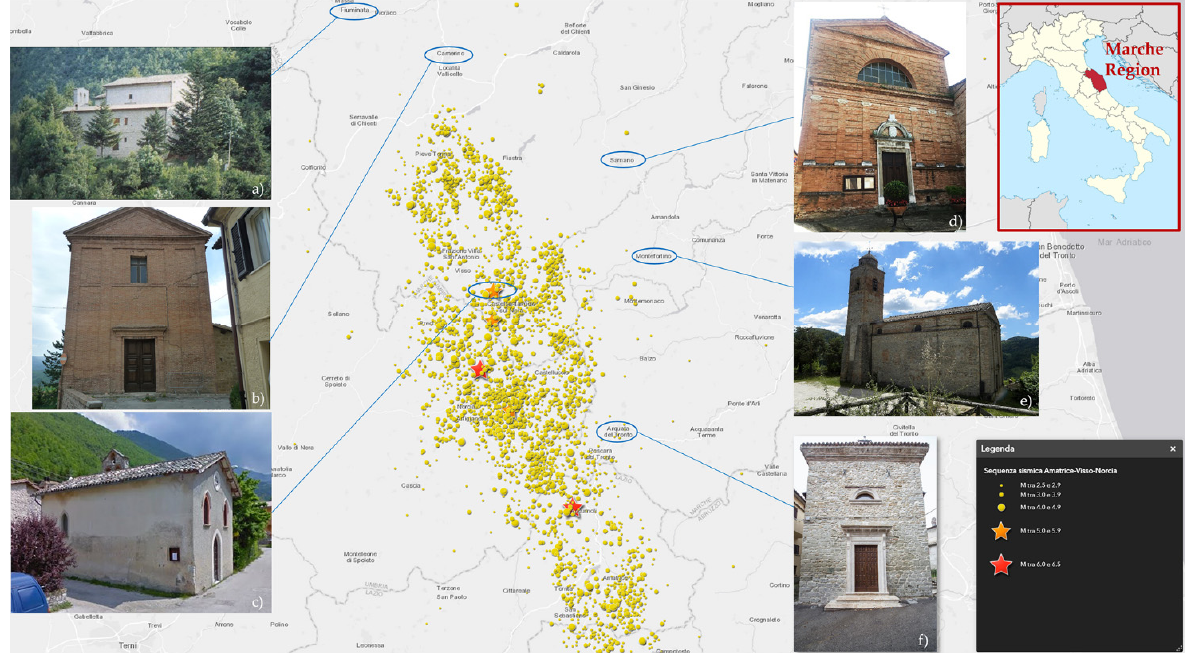
Figure 1. Churches’ locations respect to the Epicenters of Central Italy seismic sequence of 2016: Madonna of Valcora Sanctuary in Fiuminata ( a ), Sant’Anna Church in Camerino ( b ), Sant’Antonio Church in Ussita ( c ), San Francesco Church in Sarnano ( d ), San Francesco Church in Montefortino ( e ), Santissimo Crocifisso in Arquata del Tronto ( f ).